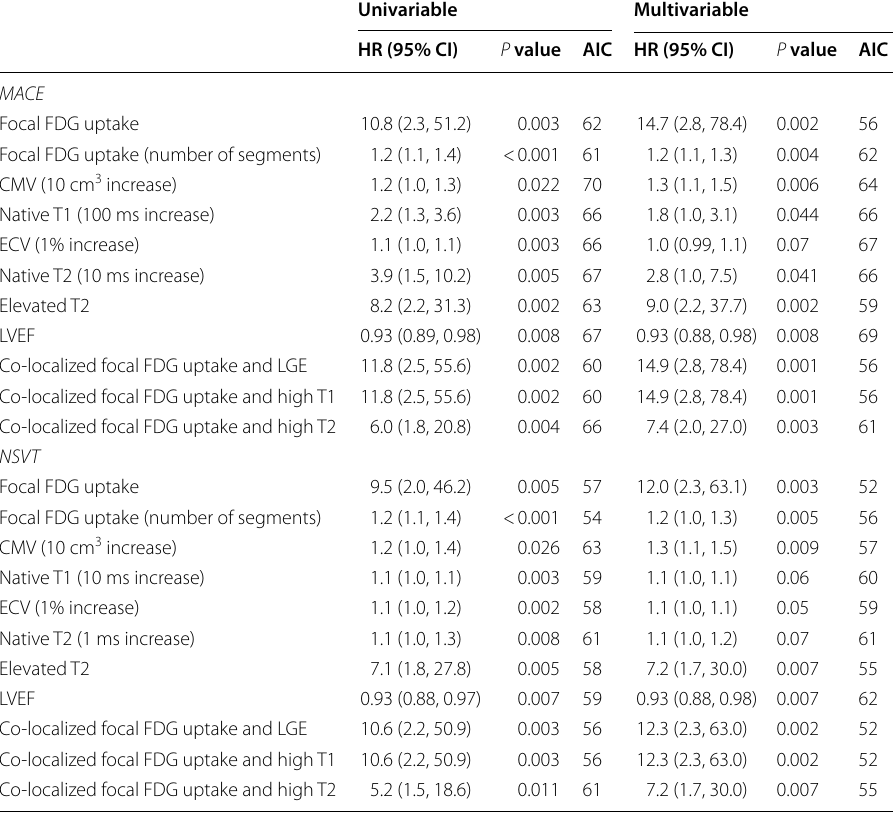
Table 4 Univariable and multivariable time‑to‑event survival analysis for primary and secondary